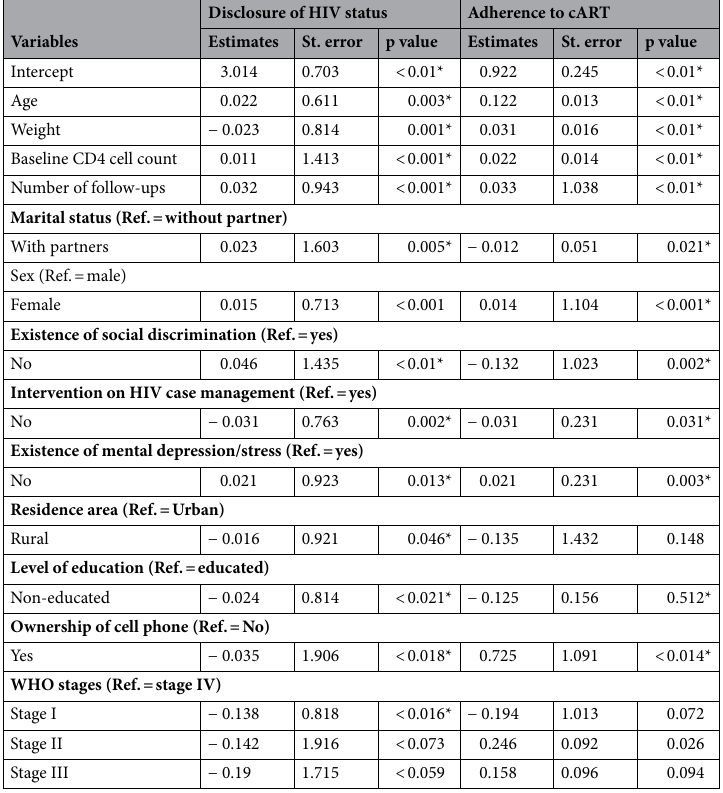
Table 2. Parameter estimates for marginal models of disclosure of HIV status and adherence to cART. *significant at 5% level of